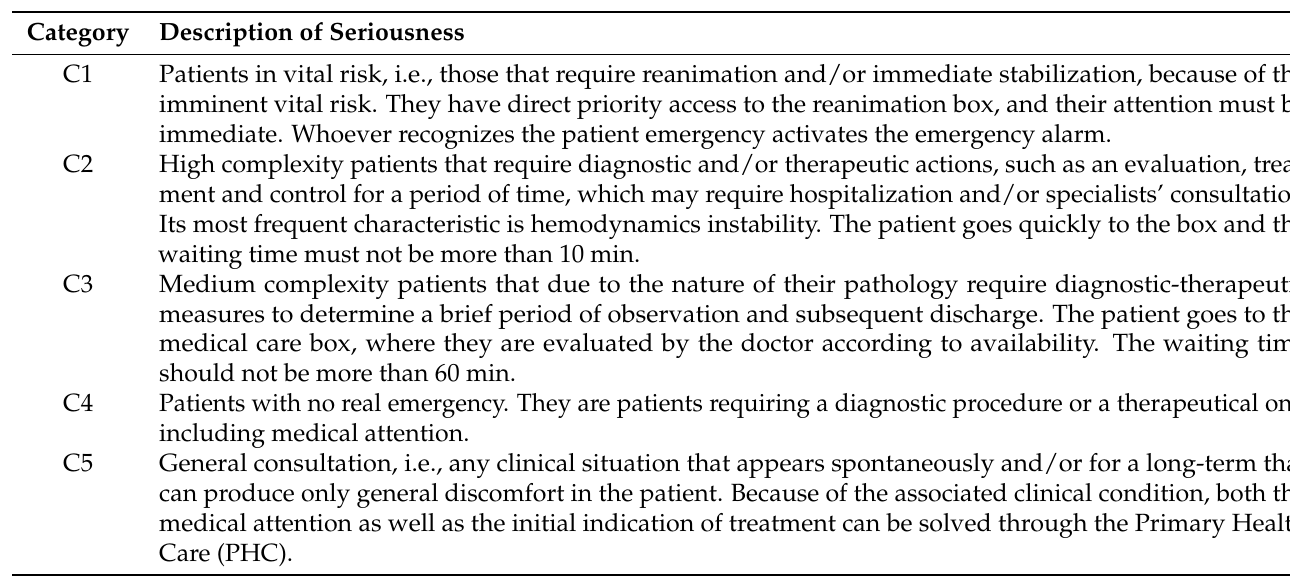
Table 2. Description of the Triage categorization